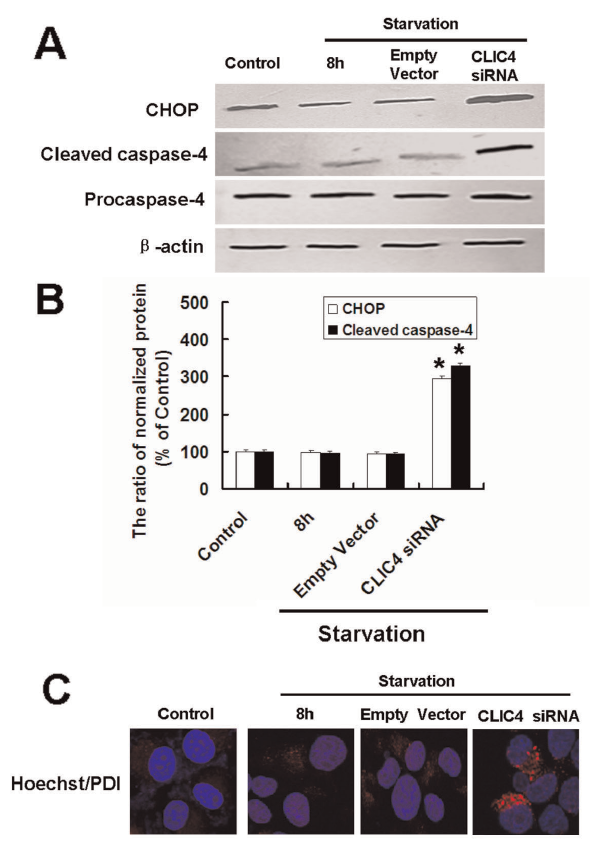
Figure 9. CLIC4 siRNA transfection triggered ER stress-induced apoptosis under starvation conditions. U251 cells transfected with a plasmid encoding empty vector or CLIC4 siRNA vector for 24 h. (A) Western blot analysis of CHOP, Procaspase-4, Cleaved caspase-4 expression in U251 cells incubated with EBSS for 8 h. (B) Densitometric analysis of normalized CHOP and Cleaved caspase-4. Standard error represents three independent experiments. * P , 0.05 versus starvation 8 h group. (C) PDI immunostaining analysis of the ER stress activation (Hoechst 33342 staining for the nucleus, 900 6 ) observed by confocal microscopy incubated with EBSS for 8